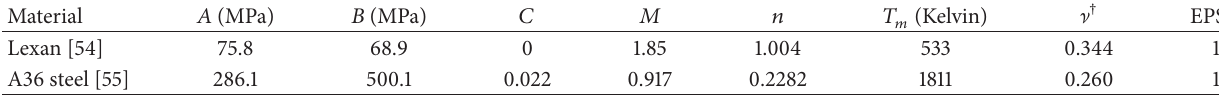
Table 3: Johnson-Cook material properties for the projectile and the target.